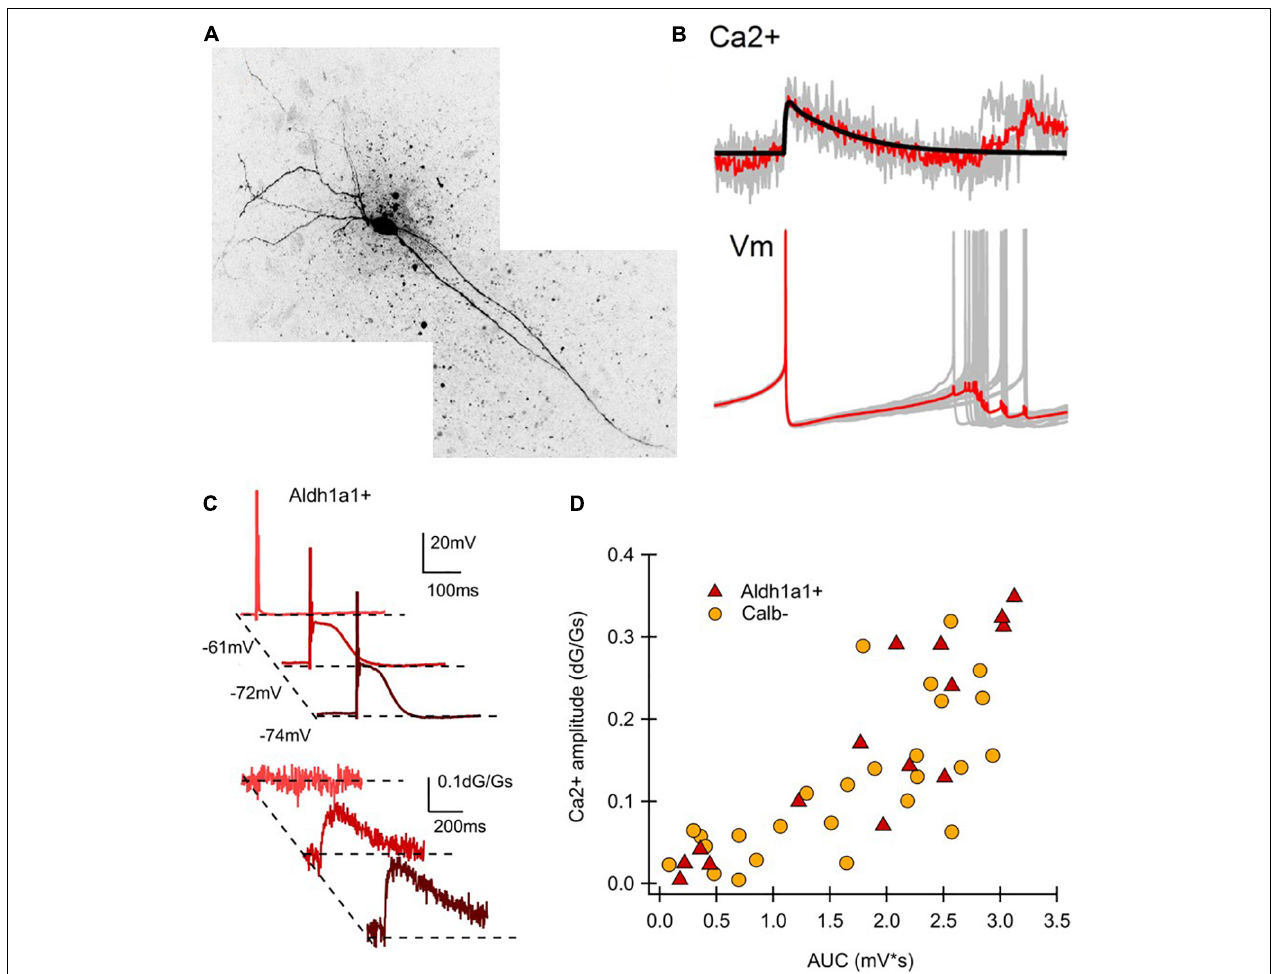
FIGURE 2 | Electrophysiological characteristics of ALDH1A1 + nDANs. (A) Two-photon image of a ALDH1A1 + nDAN. (B) Average calcium transient (above) and action potential (below) shape during tonic firing for a ALDH1A1 + nDAN. (C) Hyperpolarization-dependent after depolarizations (above) and corresponding dendritic calcium transients (below) for a ALDH1A1 + nDAN. (D) Amplitude of the calcium transient from a potential of − 80 mV graphed by the area under the curve (AUC) for the corresponding low-threshold depolarization. Calb - , Calbindin-negative population (data re-graphed from Evans et al., 2017, (D) , adult heated calbindin-negative